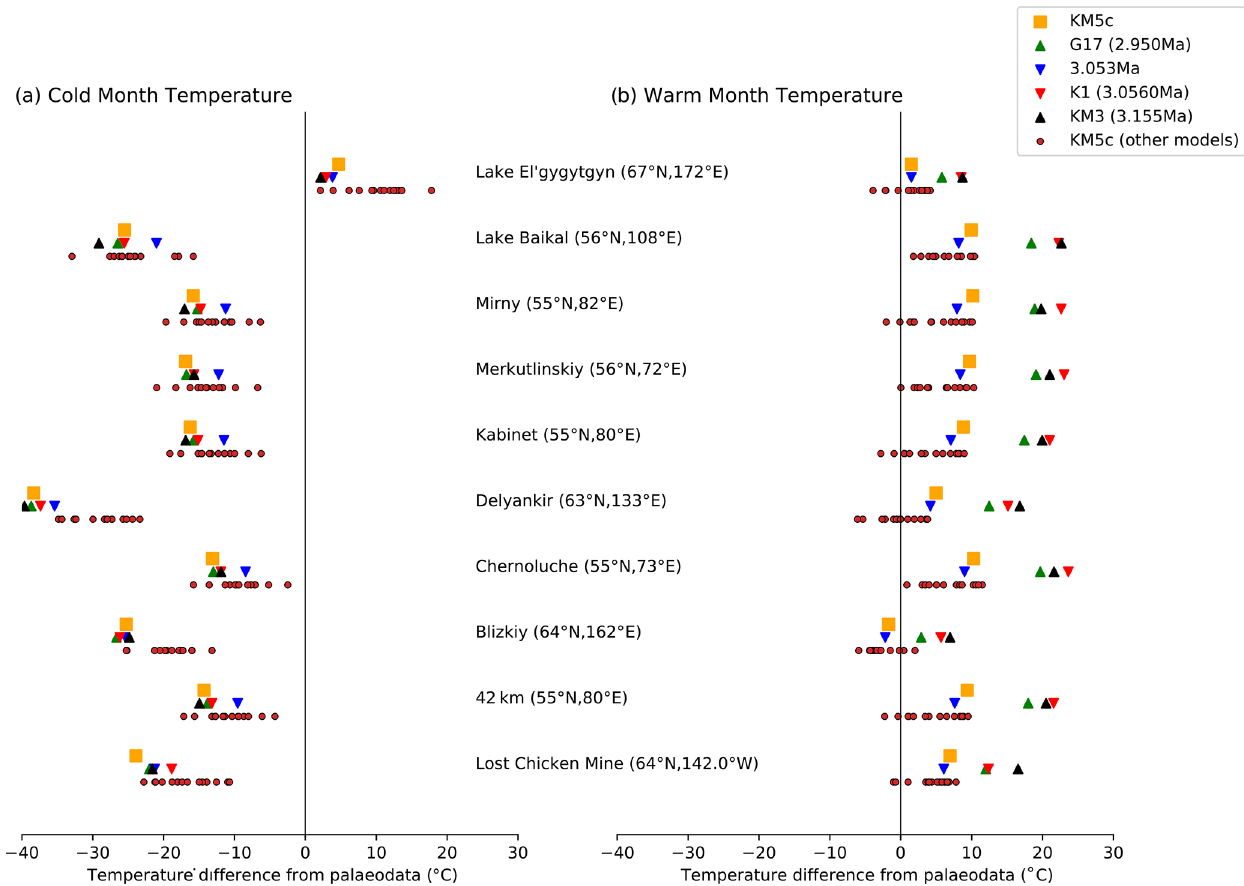
Figure 6. The difference between the modelled temperature and the palaeodata. The palaeodata are dated to KM5c for Lake Baikal and Lake El’gygytgyn and are dated to the late Pliocene for other sites. HadCM3 simulations with a range of different orbital configurations are shown by the square and triangles. The KM5c simulation for other models is shown by the